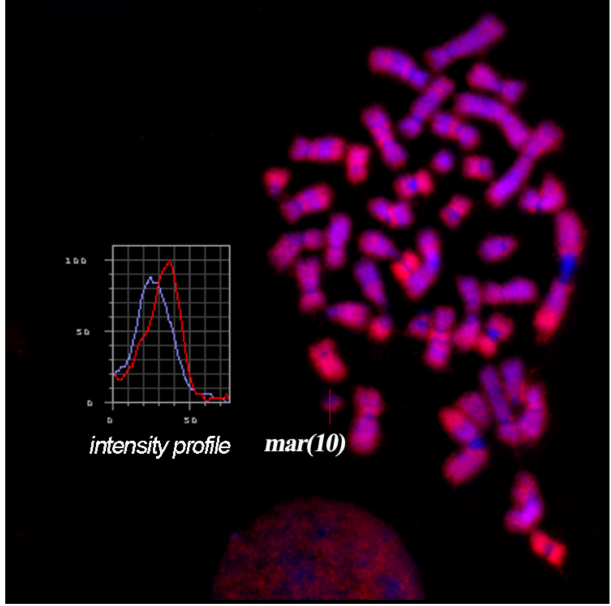
Figure 4. FISH with an Alu-DNA probe on foetal metaphase chromosomes. The profile of the intensity of the FISH signal and DAPI staining along the sSMC is presented in the block. Fluorescence intensity measurement along the sSMC is indicated by the red line, while the intensity of DAPI staining is shown with the blue